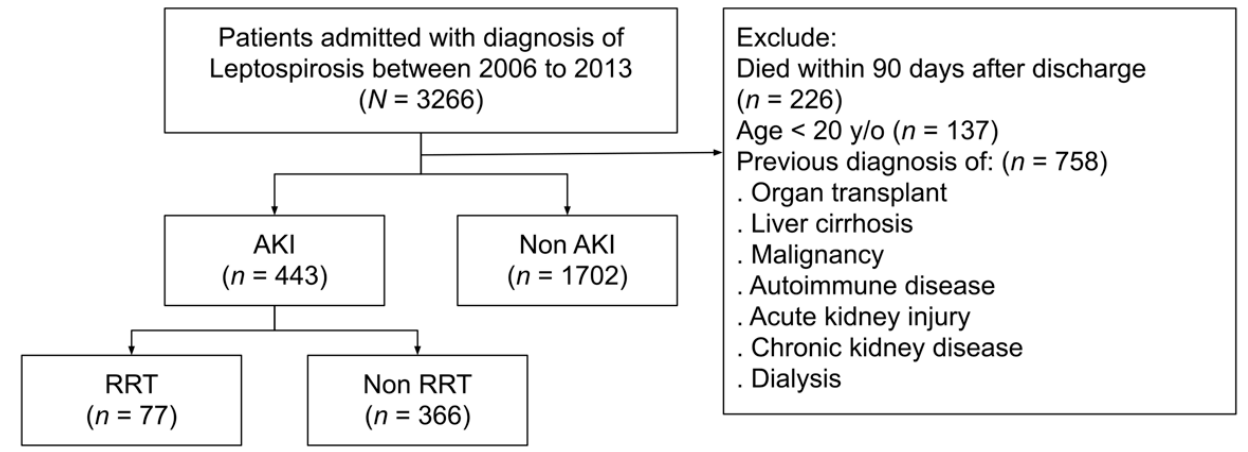
Figure 1. Selection of the study patients.